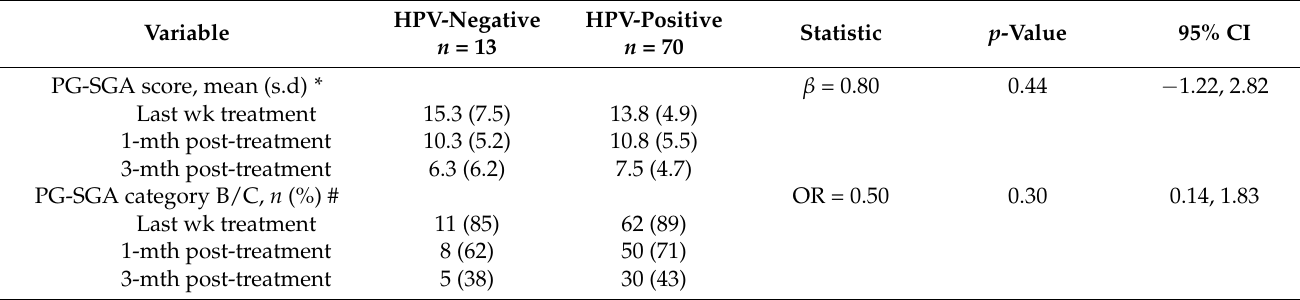
Table 2. Primary outcome: HPV-positive and HPV-negative in a linear mixed model of mean PG-SGA score and category across end of treatment, 1 months and 3 months post